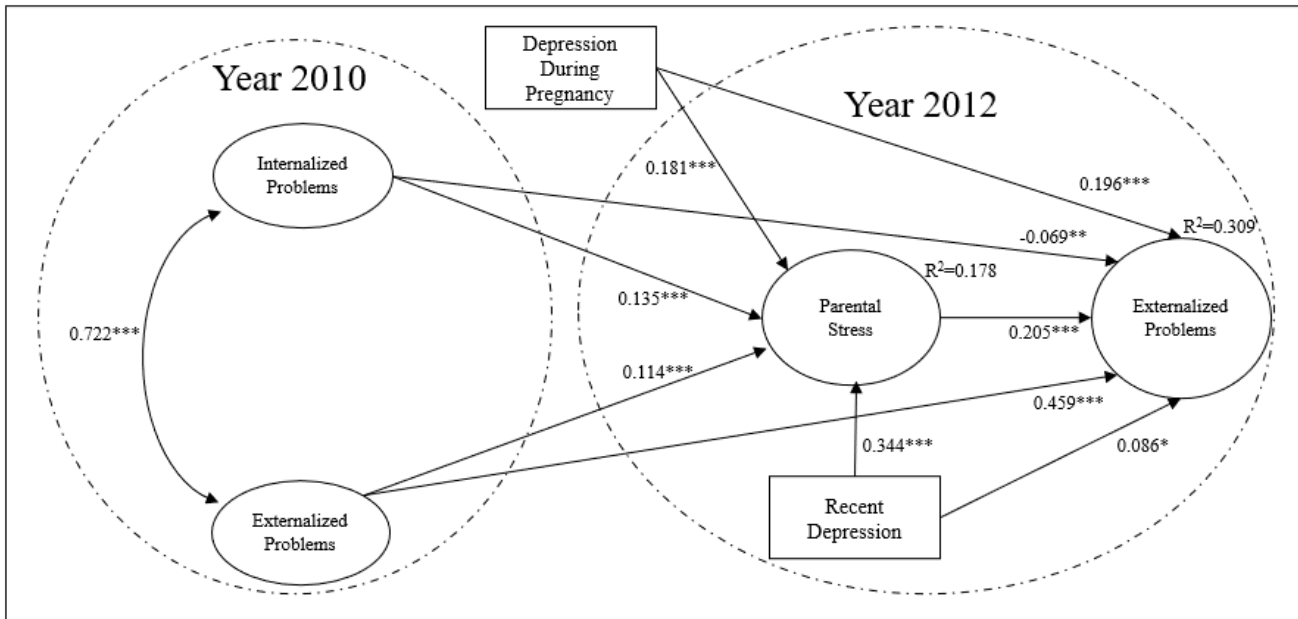
Figure 1. Explanatory model of externalized problems. “***” p < 0.001, “**” p < 0.01, “*” p < 0.05. The standardized β s are presented for the latent variables, and the non-standardized β s for the observed variables. Only the statistically significant associations of the most relevant variables from the theoretical point of view are presented in this study.